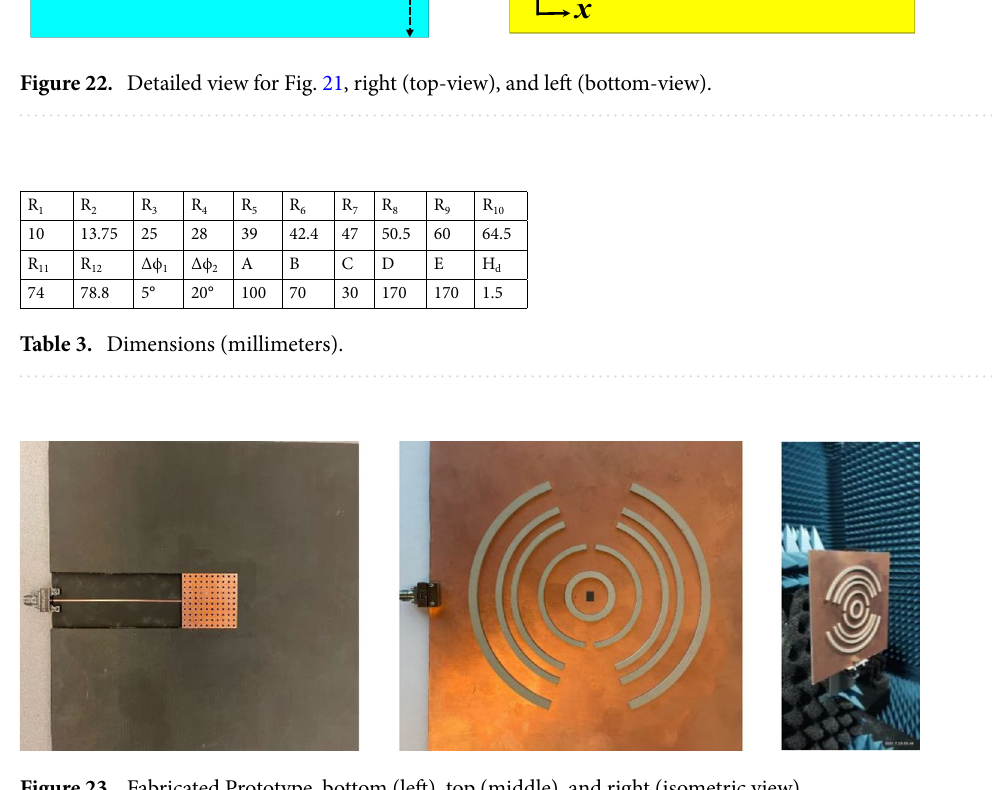
Figure 23. Fabricated Prototype, bottom (left), top (middle), and right (isometric view).